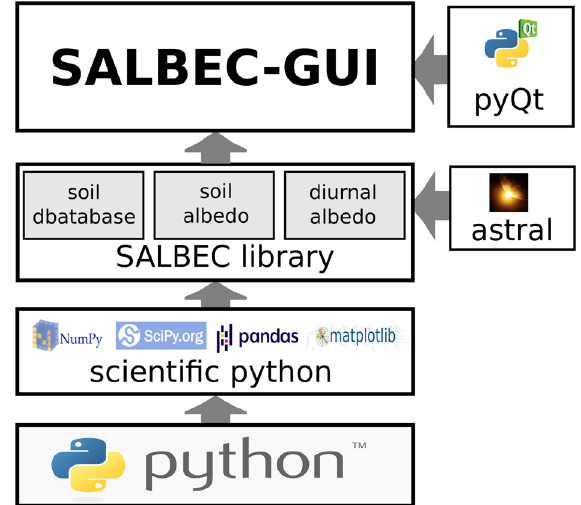
Fig. 4. The architecture of SALBEC software. SALBEC, Soil ALBEdo